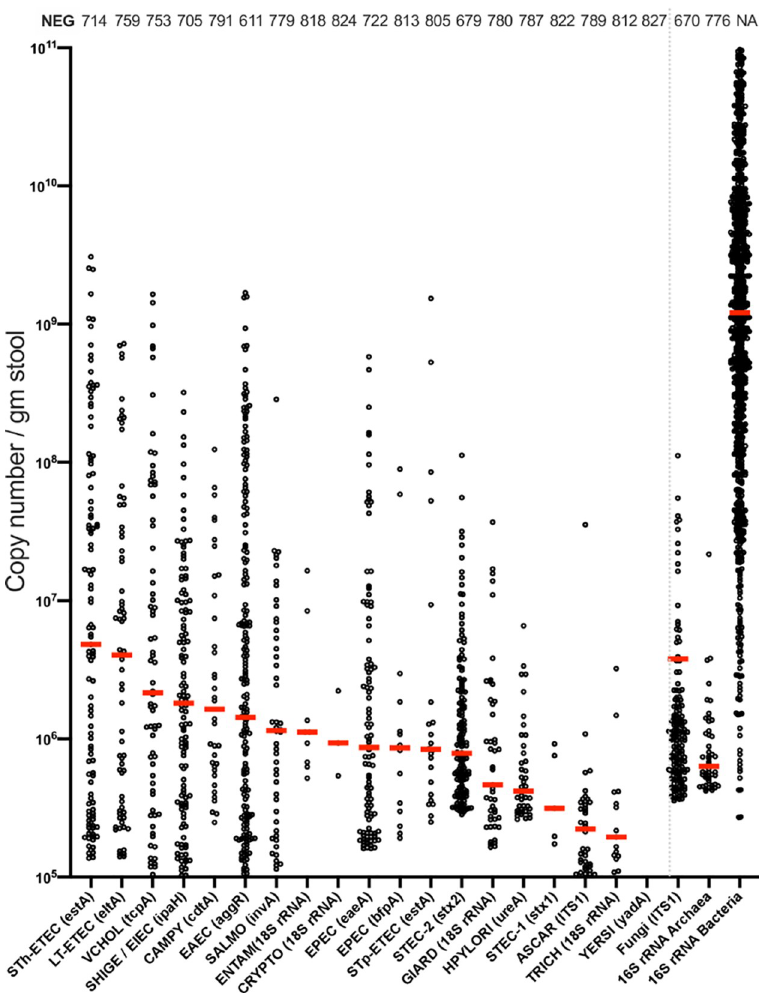
Fig 2. Enteropathogens detected by nl-qPCR. Red lines represent the median copy number per gram of stool. Vertical gray dotted line demarcates analysis of total Fungi, total Archaea, and Bacteria. Genetic targets are provided in brackets. Abbreviations are heat-labile and heat-stable enteropathogenic Escherichia coli (LT-ETEC and ST-ETEC), Vibrio cholerae (VCHOL), Shigella spp. (SHIGE), typical enteroaggregative Escherichia coli (EAEC), Salmonella spp. (SALMO), Campylobacter jejuni/coli (CAMPY), enteropathogenic Escherichia coli (EPEC), Giardia lamblia (GIARD), Shiga-toxin producing Escherichia coli (STEC), Entamoeba histolytica (ENTAM), Ascaris lumbricoides (ASCAR), Cryptosporidium supp (CRYPTO), Trichuris trichiura (TRICH), Helicobacter pylori (HPYLO), and Yersinia enterocolitica (YERSI); see Methods and S1 Table. NEG =